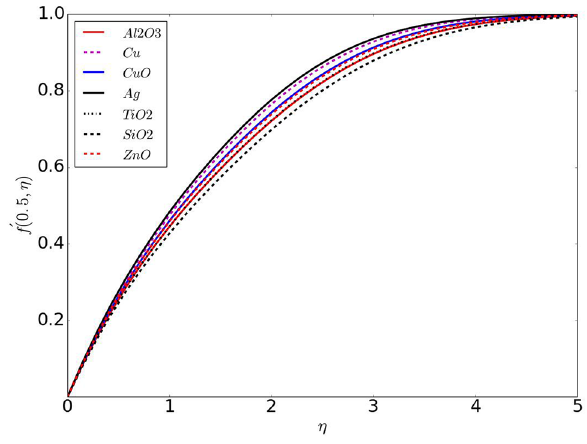
Fig. 20 Variation on Cf rd with 𝜉 = 0.5 and 𝜙 = 0.05 for various nano- fluids